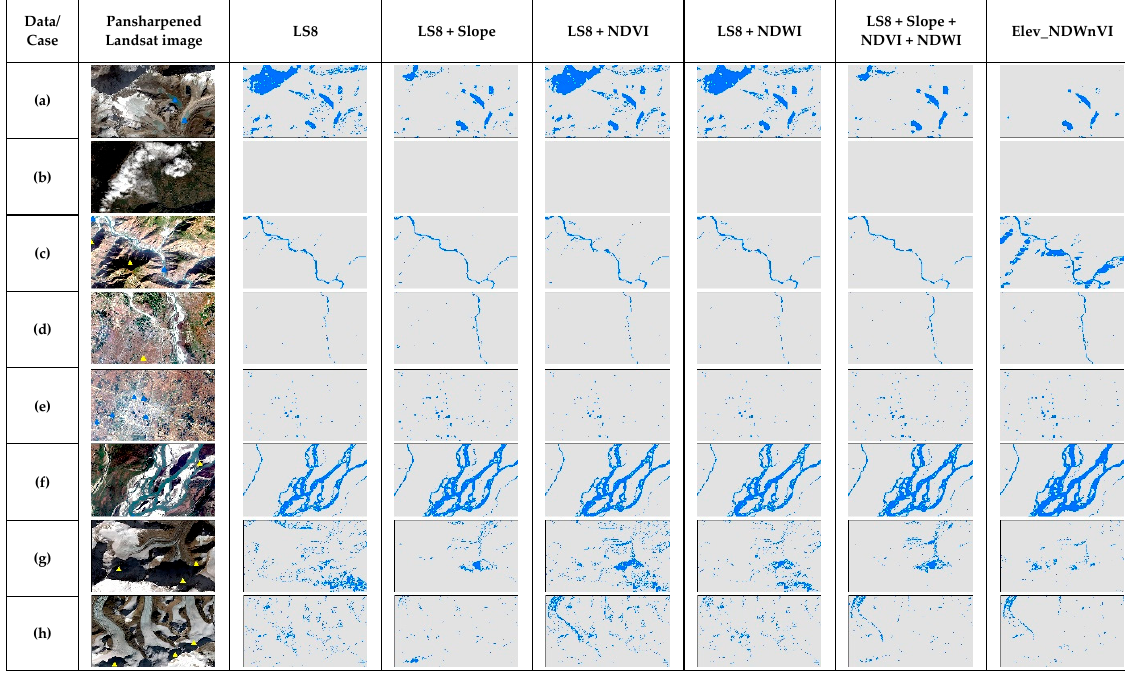
Figure 11. The comparison of GBM results of special cases of surface water in the test scene (Figure 1) for different multiband data used.